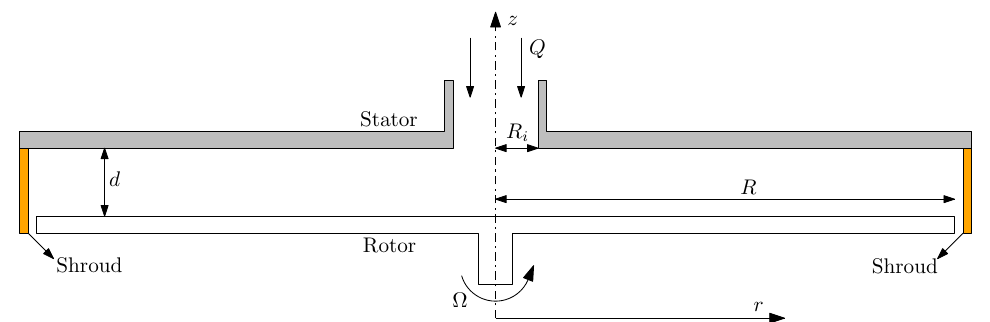
Figure 2. Schematic illustration of the AFPM